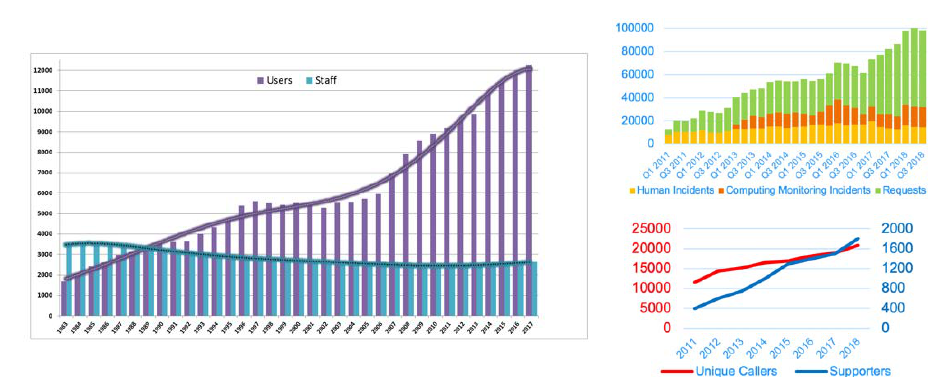
Fig. 1. CERN Users vs Staff evolution, and growth of Service Management at